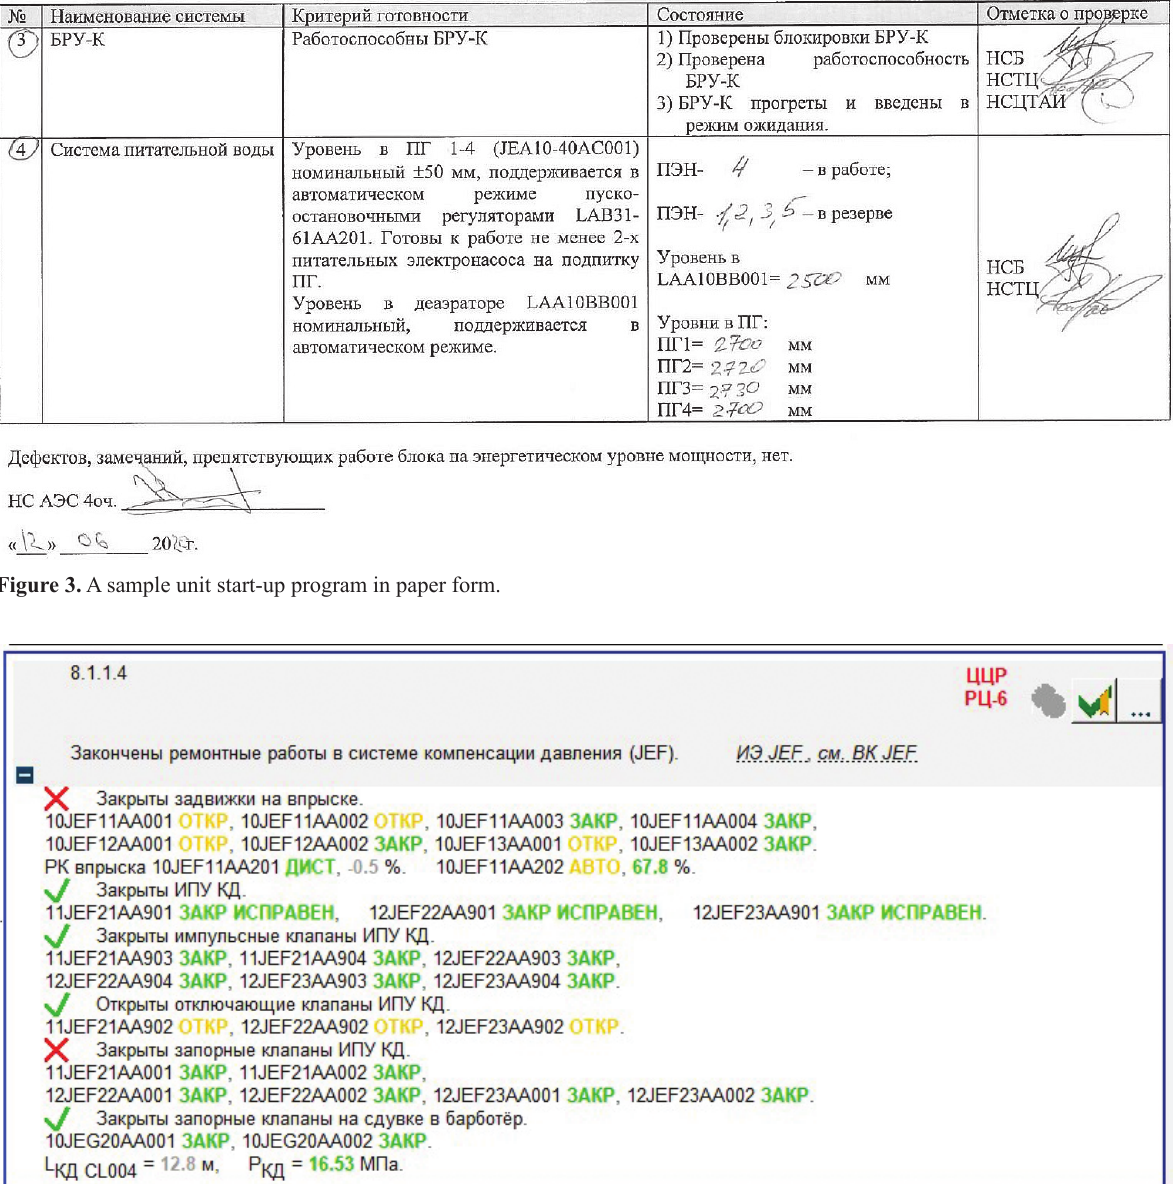
Figure 4. Collection and presentation of information in the interactive